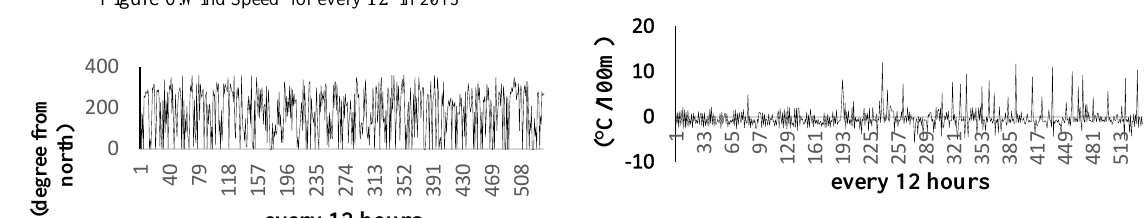
Figure 13 . Temperature inversion for every 12 ℎ in